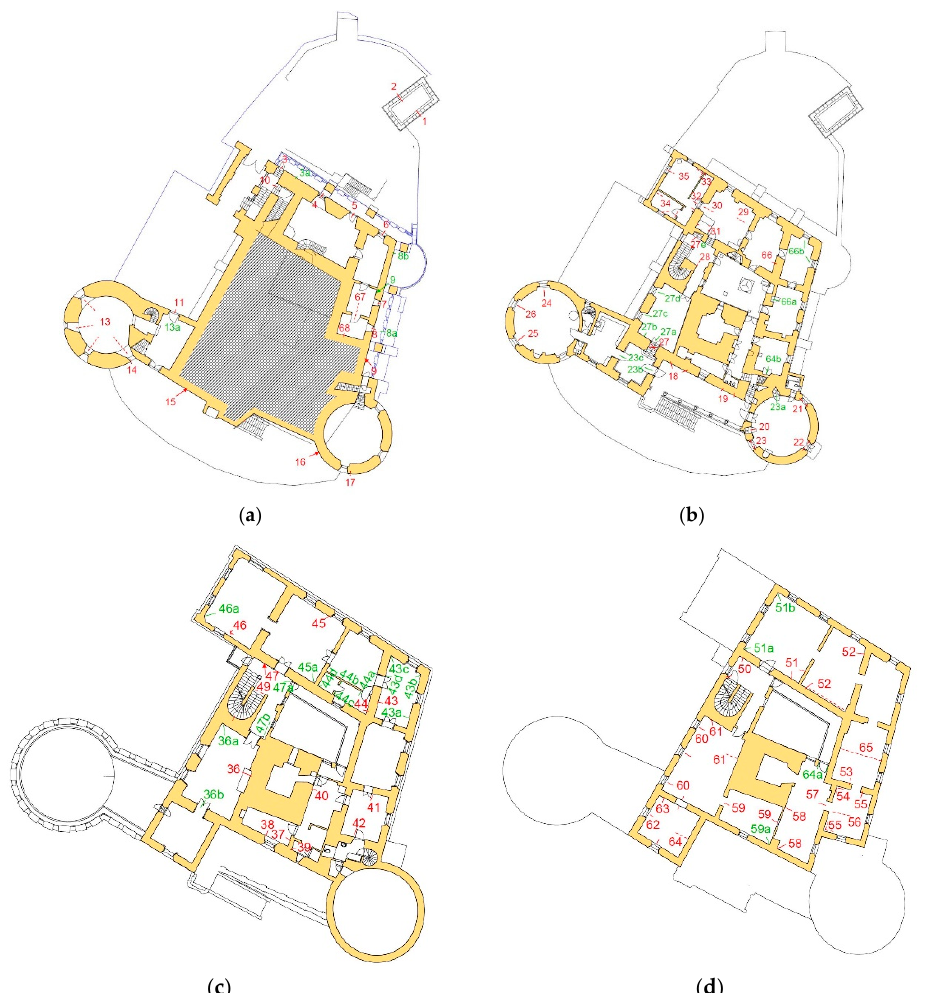
Figure 10. Map of crack positions observed during the in situ visual inspection: ( a ) Basement; ( b ) Ground floor; ( c ) First floor; ( d ) Second floor (note: red colored marks designate the damage after the Zagreb M5.5 2020 earthquake and green colored marks designate damage after the Petrinja M6.2 2020 earthquake).